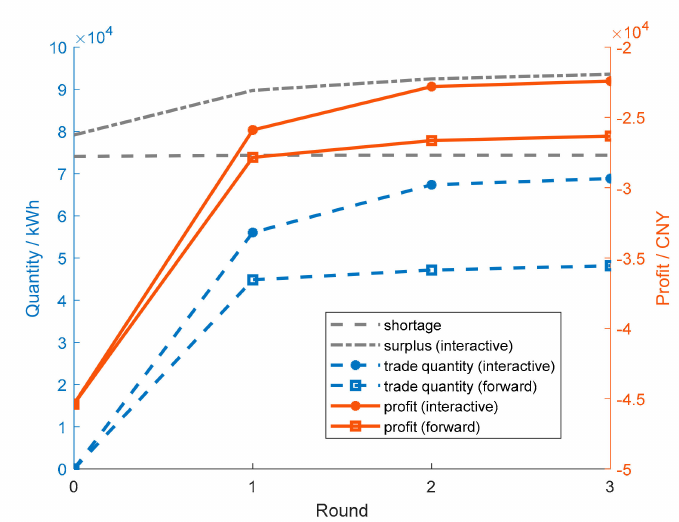
Figure 11. Comparison of the total trade quantities and total profits between two